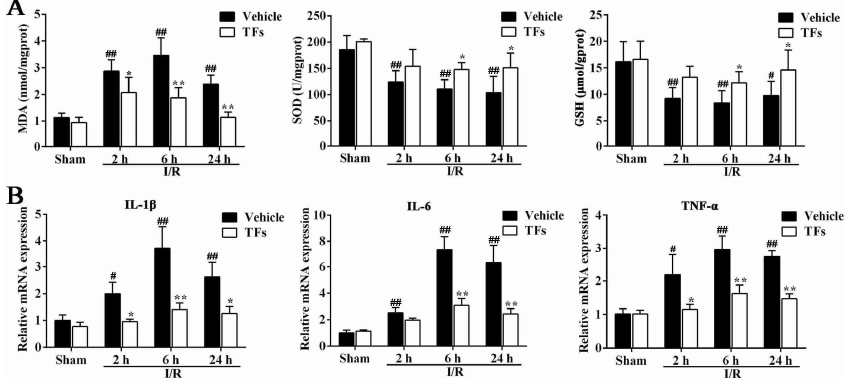
Figure 3. TFs inhibited I/R-induced oxidative stress and inflammation after I/R injury. ( A ) Effects of TFs on MDA, SOD, and GSH activities in liver tissue after 1 h of ischemia and different times of reperfusion (2 h, 6 h, and 24 h); and ( B ) effects of TFs on the mRNA levels of IL-1 β , IL-6, and TNF- α in liver tissue after 1 h of ischemia and different times of reperfusion (2 h, 6 h, and 24 h). Data are presented as the mean ˘ SD ( n = 6). # p < 0.05 and ## p < 0.01 versus sham; * p < 0.05 and ** p < 0.01 versus